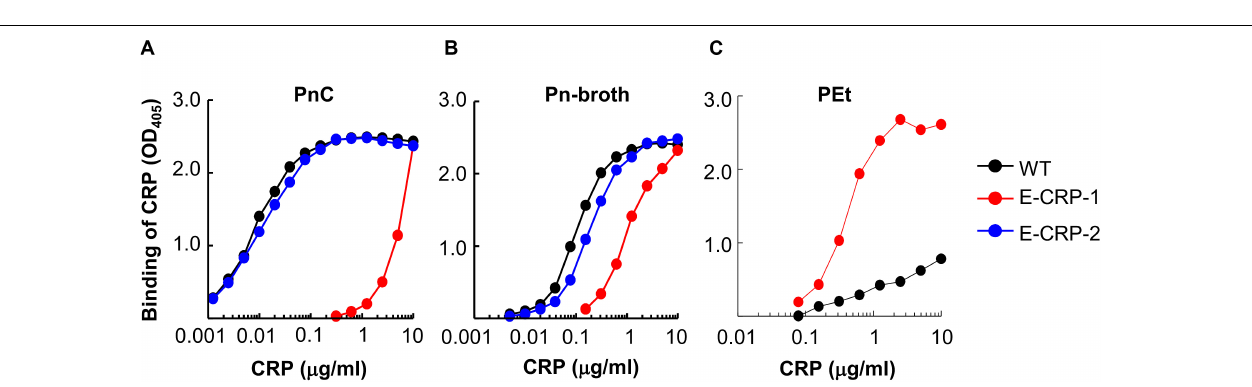
FIGURE 1 | E-CRP-1 and E-CRP-2 are pentameric. (A) Elution profiles of E-CRP-1 (left panel) and E-CRP-2 (right panel) from the gel filtration column. (B) SDS-PAGE of WT CRP (lanes 2, 5), E-CRP-1 (lane 3) and E-CRP-2 (lane 6). A representative of three experiments is shown for each panel.